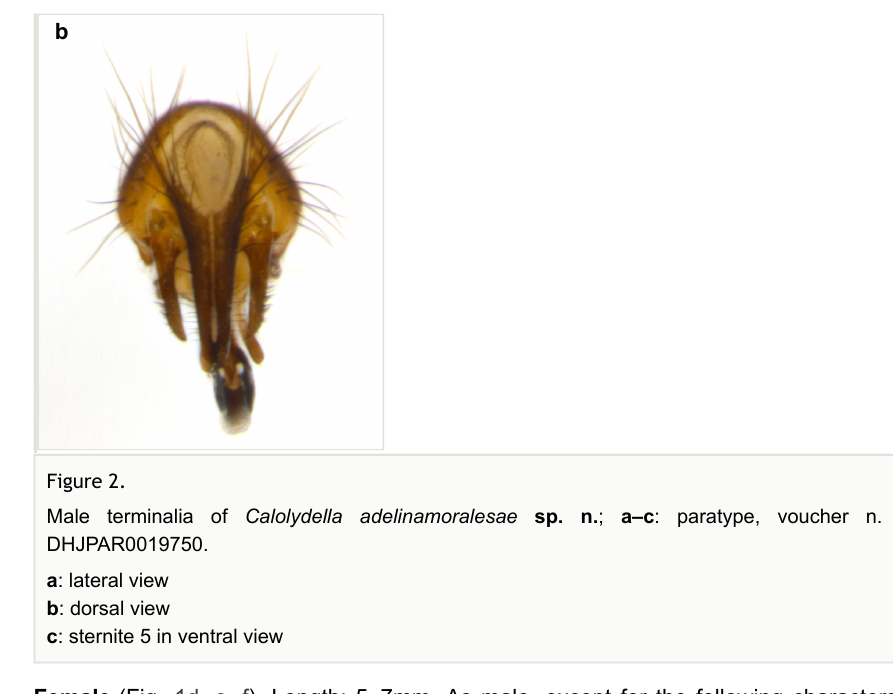
Female (Fig. 1d, e, f). Length: 5–7mm. As male, except for the following characters: fronto-orbital plate 1.6X as wide as in male; 2:3 acrostichal setae; wing vein R with 6–7 setulae extending to crossvein R-M, and ground color of abdomen appearing slightly darker than in male.